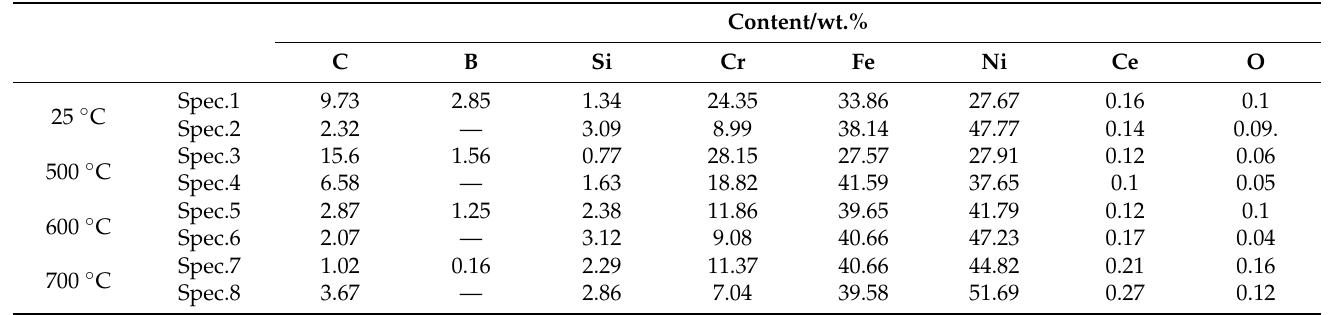
Table 2. EDS results of the coating.